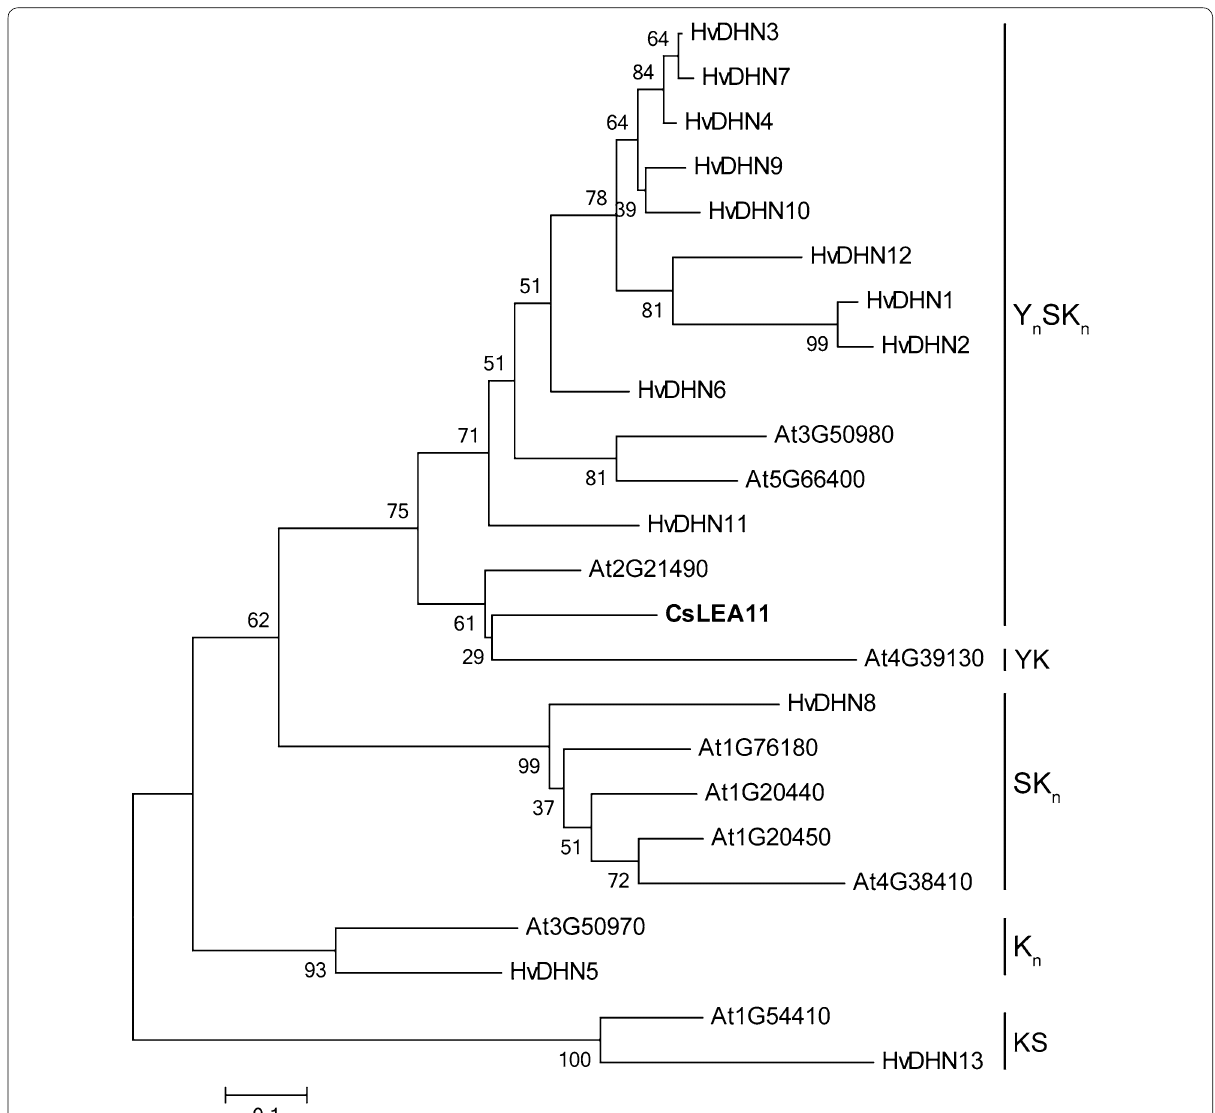
Fig. 3 Phylogenetic tree of amino acid sequences from CsLEA11 and DHNs from other plant species including Arabidopsis and barley. The tree was constructed with MEGA 5.0 program using neighbor-joining method with 1000 bootstrap replicates. The amino acid sequences used to generate the phylogenic tree were listed in Additional file 1: Table